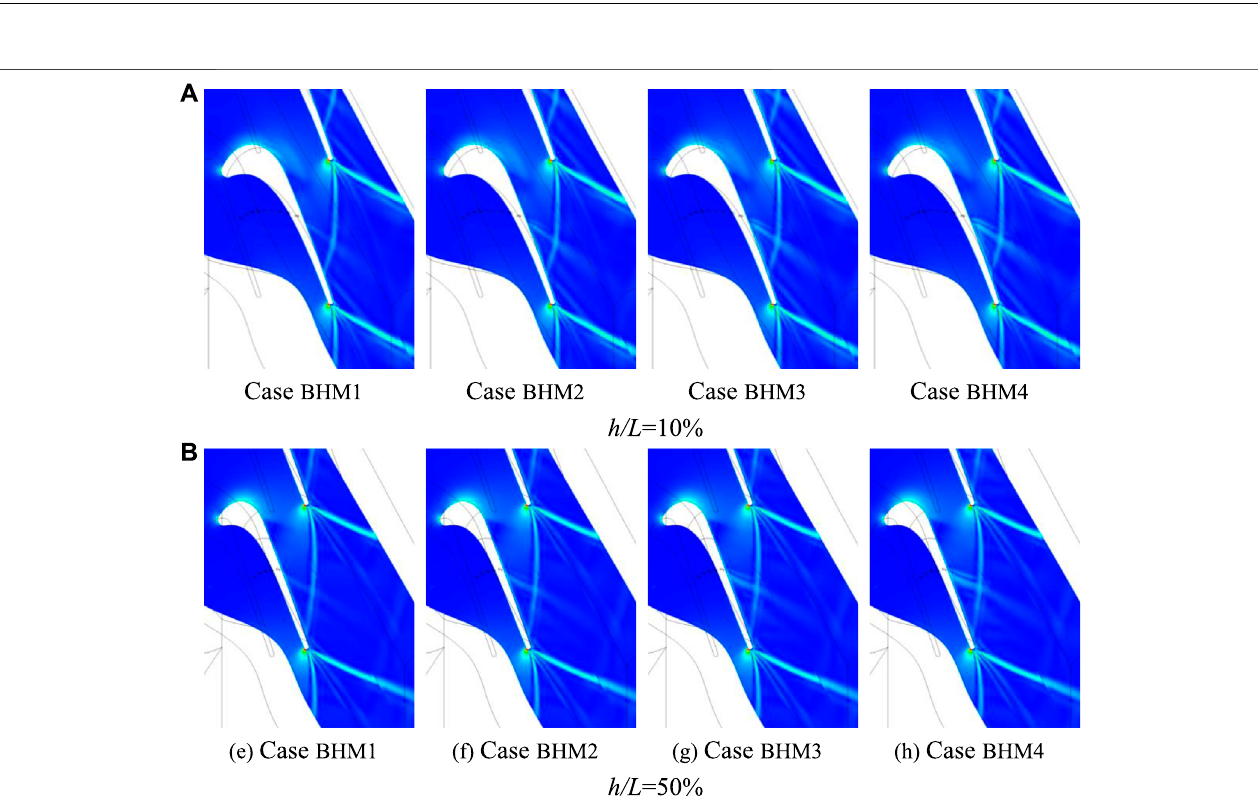
Frontiers in Energy Research |